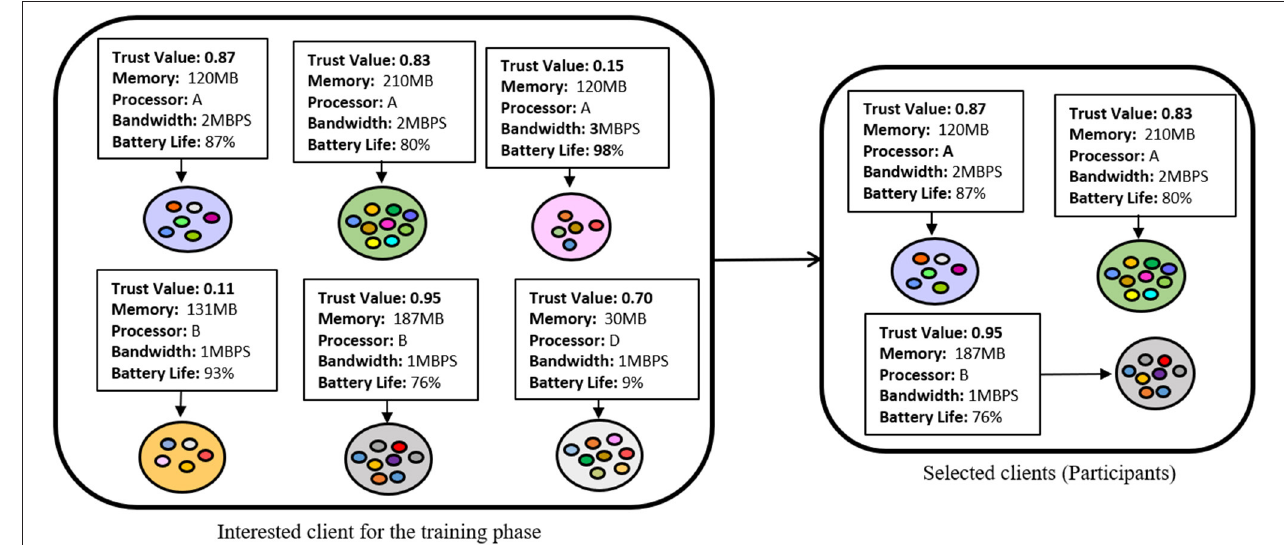
FIGURE 2 | Client selection based on resource-availability and trust score.